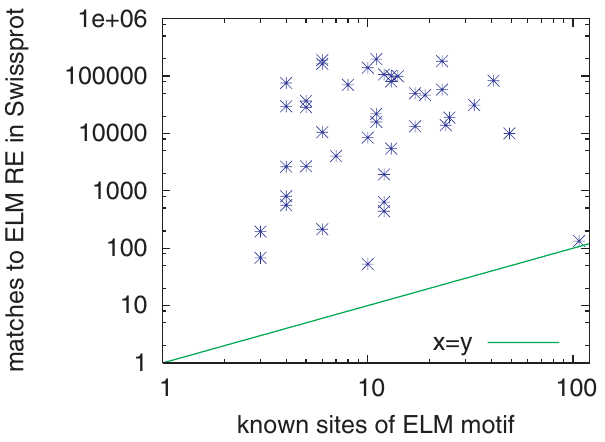
Figure 3. Non-specificity of ELM motif regular expressions. Each point represents one of the 41 ELM motifs used in this study. The x - value of the point is the number of known sites, and y gives the number of predicted sites in Swiss-Prot sequences.